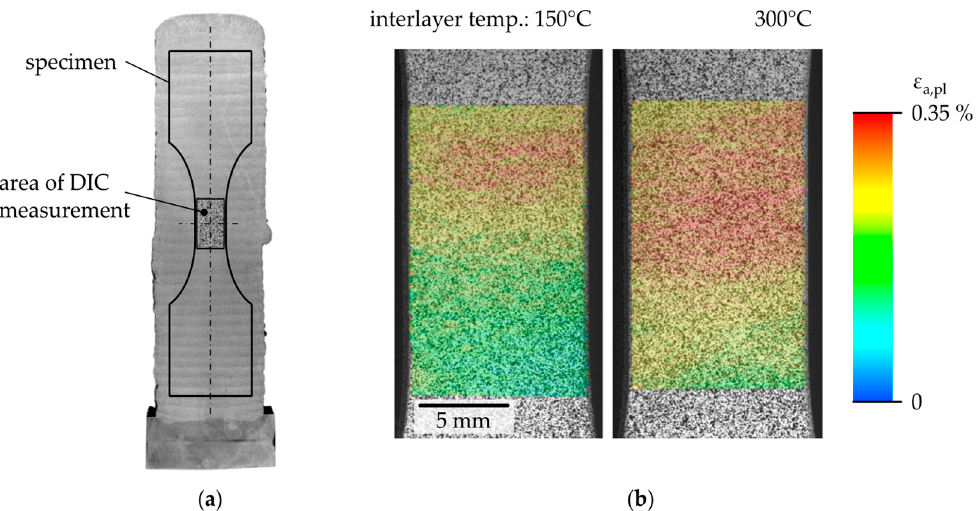
Figure 13. Strain measurements with digital image correlation of flat specimens. ( a ) Specimen geometry and extraction position, ( b ) digital image correlation (DIC) results for the plastic strain amplitude within the parallel region of the specimen.